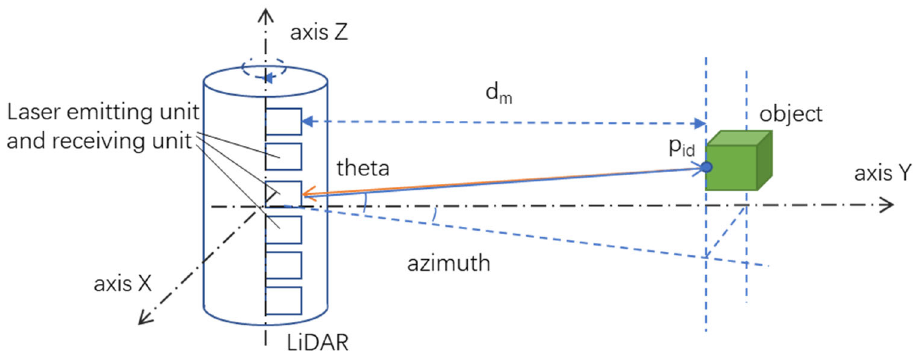
Figure 3. The schematic diagram of mechanical rotating LiDAR.